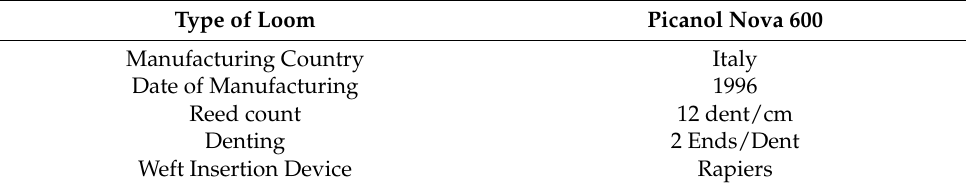
Table 2. Specifications of the machine used for preparing